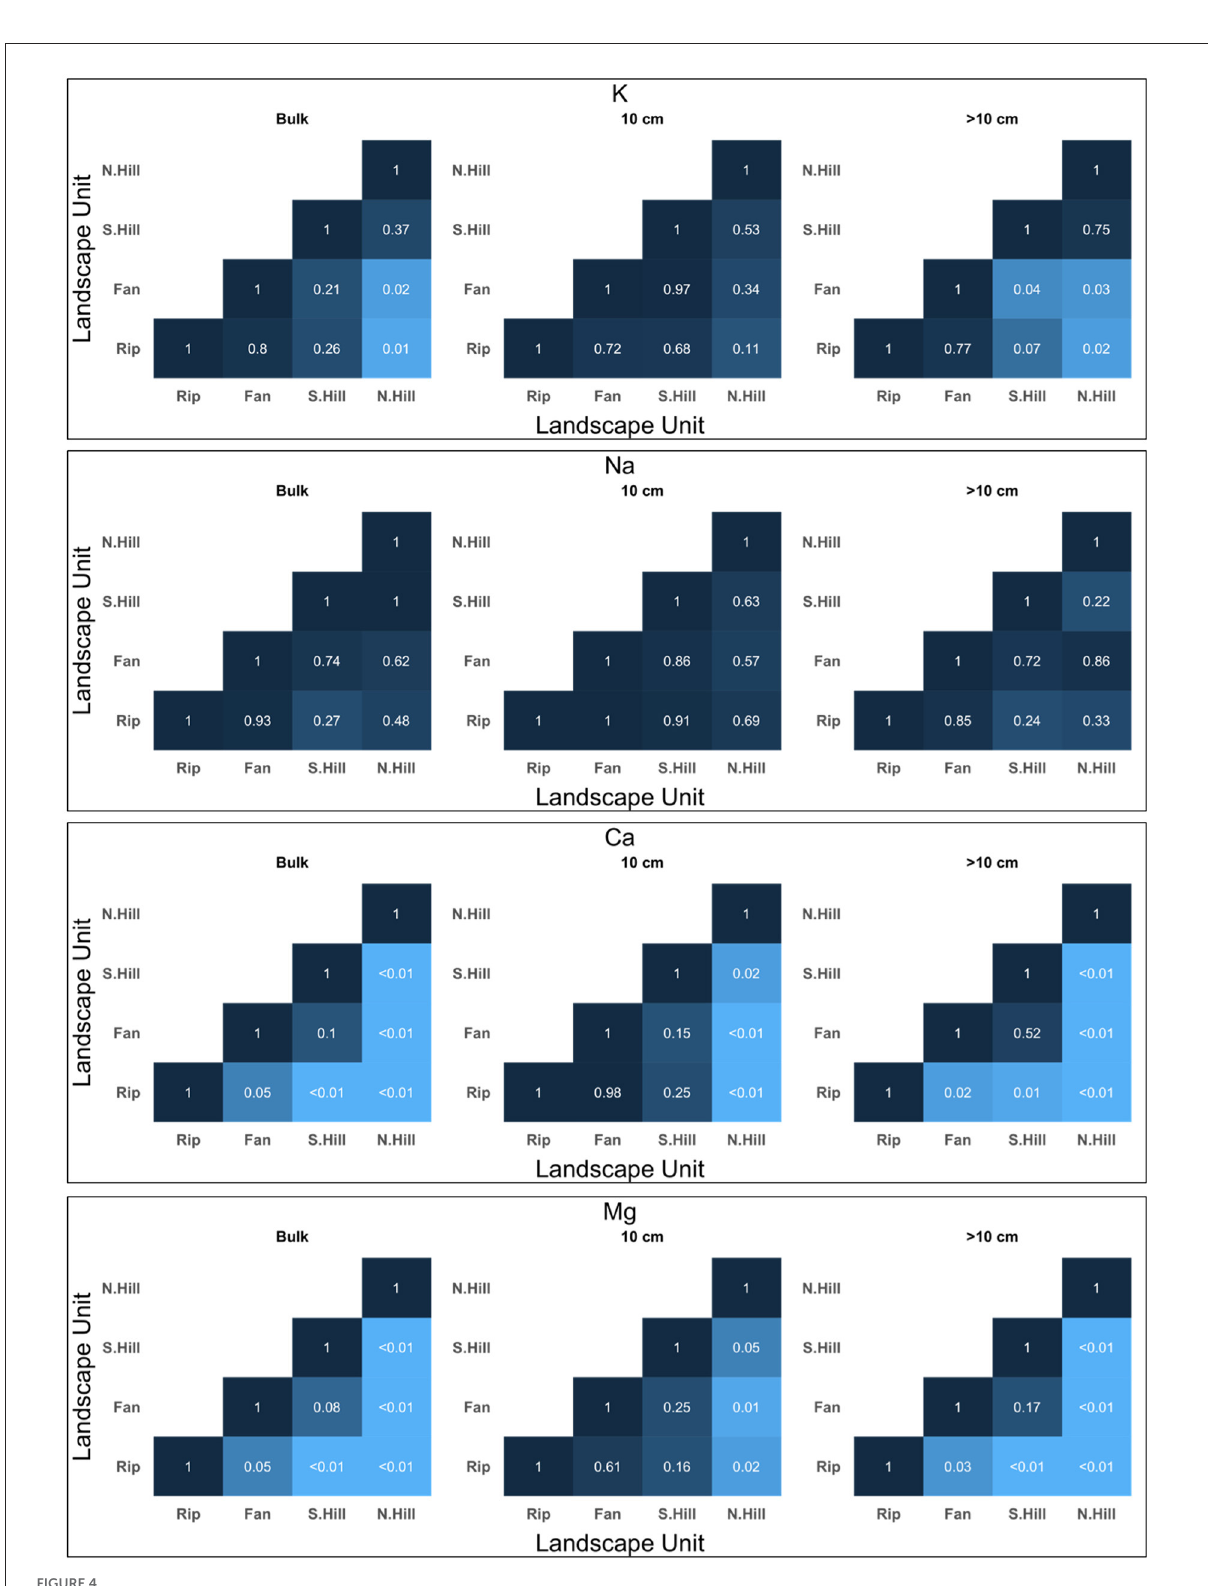
FIGURE4 Significance matrices for non-parametric t -test comparisons of soil extract cations among different landscape units at each depth. The shade of the comparison is dependent on the level of significance, with lower p -values being lighter, and higher p- values being darker. Matrices shown are limited to solutes which were used for molar ratio comparisons with stream